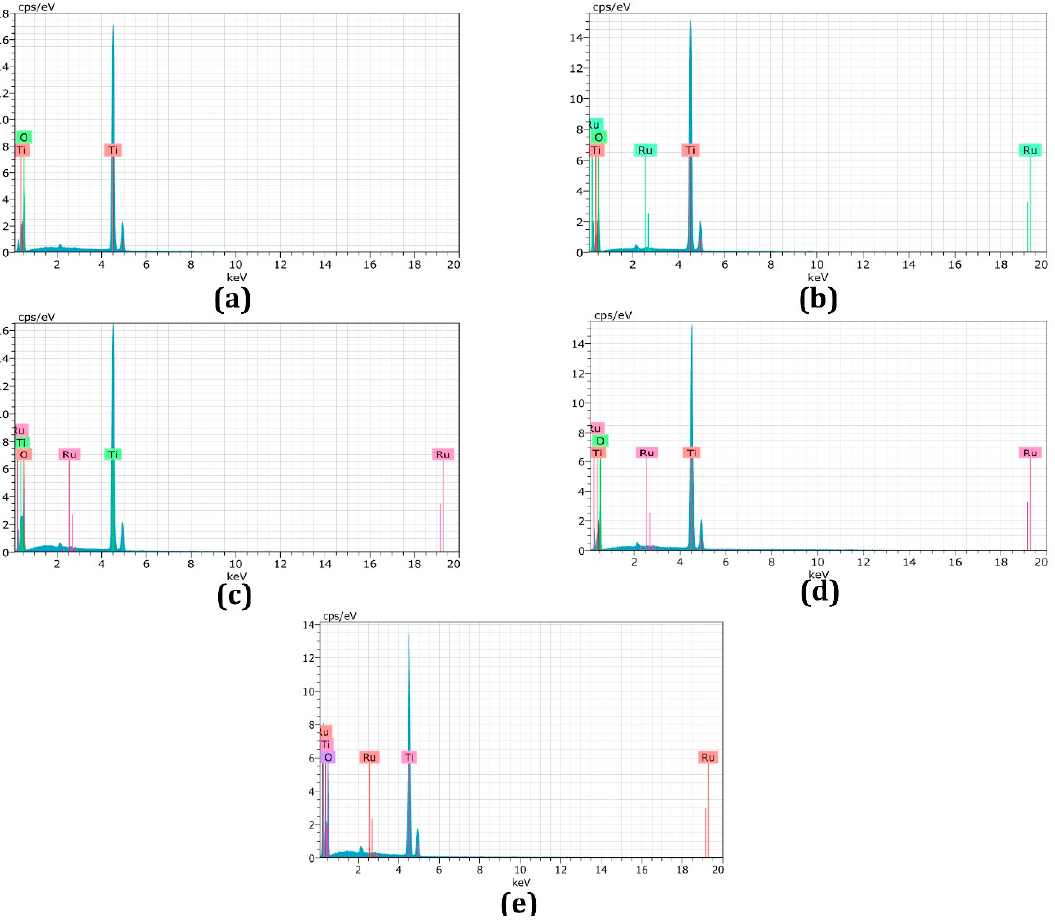
Figure 5. ( a – e ) EDX spectra of undoped and 0.15, 0.3, 0.45, 0.6 Ru-doped TiO 2 nanomaterials in the binding energy region from 0.0 to 20.0 KeV. Table 1. Atomic percentage of Ru-doped TiO 2 in terms of energy-dispersive X-ray (EDX) investigation. Samples EDX Result-Ru at.